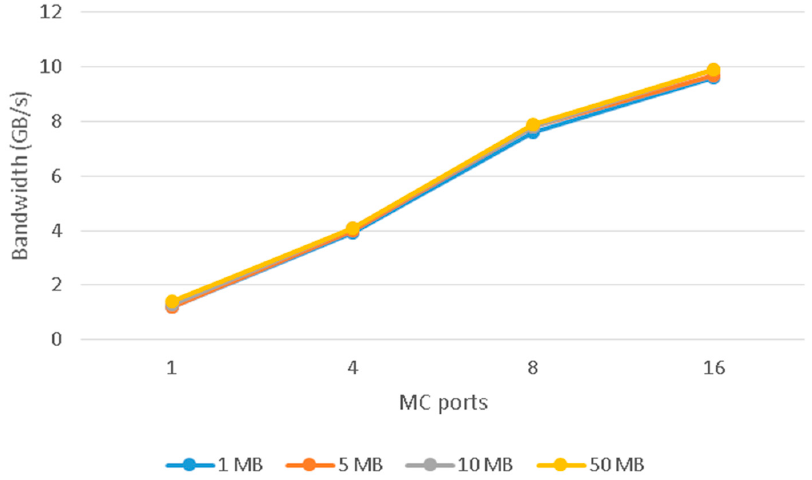
Figure 8. Bandwidth measurement. Comparison of bandwidth using different numbers MC ports